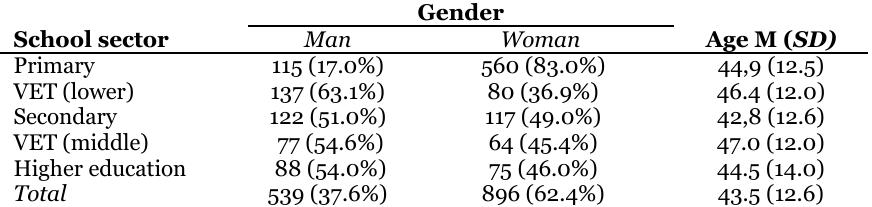
Teachers Distributed Over School Sector, Gender, and Age (N= 1435)